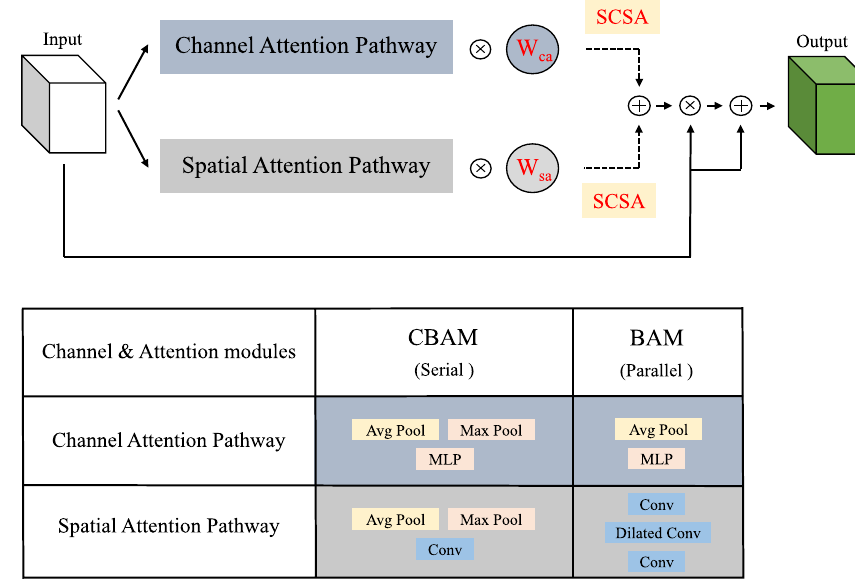
Fig. 5 The WCSA structure and the SCSA